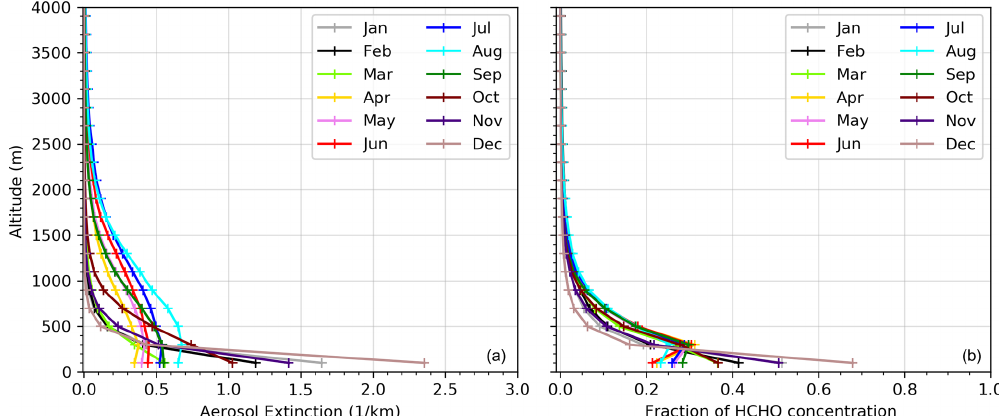
Figure F16. Monthly mean aerosol extinction profiles (a) retrieved from MAX-DOAS O 4 measurement and HCHO profiles (b) over Mohali at around the OMI overpass time